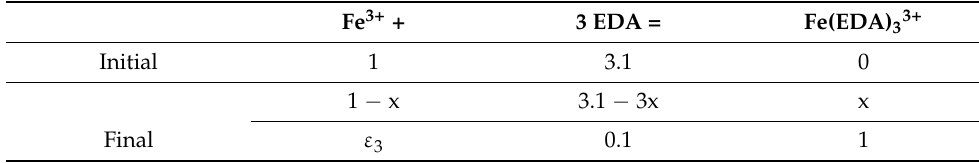
Table 3. Extent of the reaction for Fe 3+